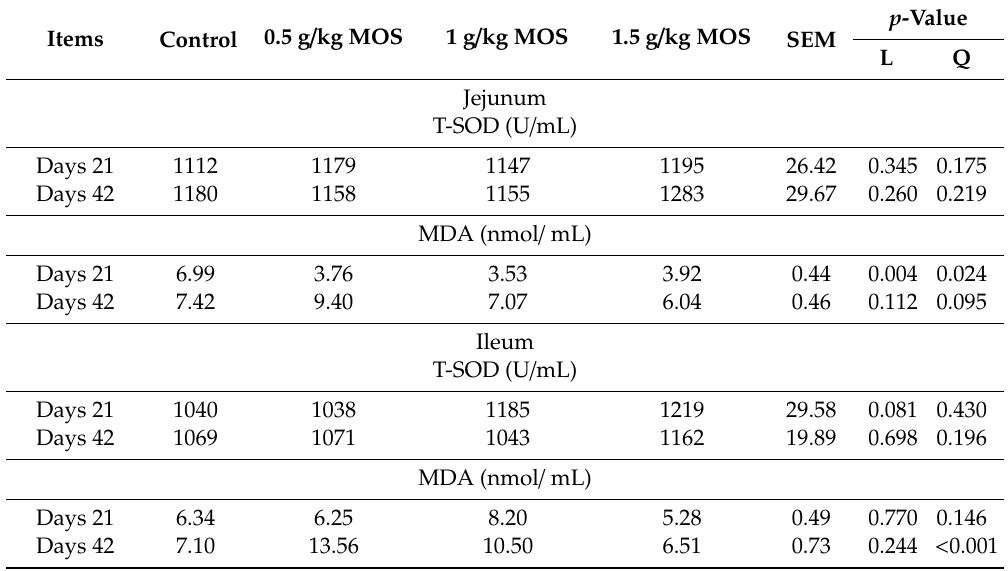
Table 6. Intestinal antioxidant status of Partridge Shank chickens fed diets supplemented with or without